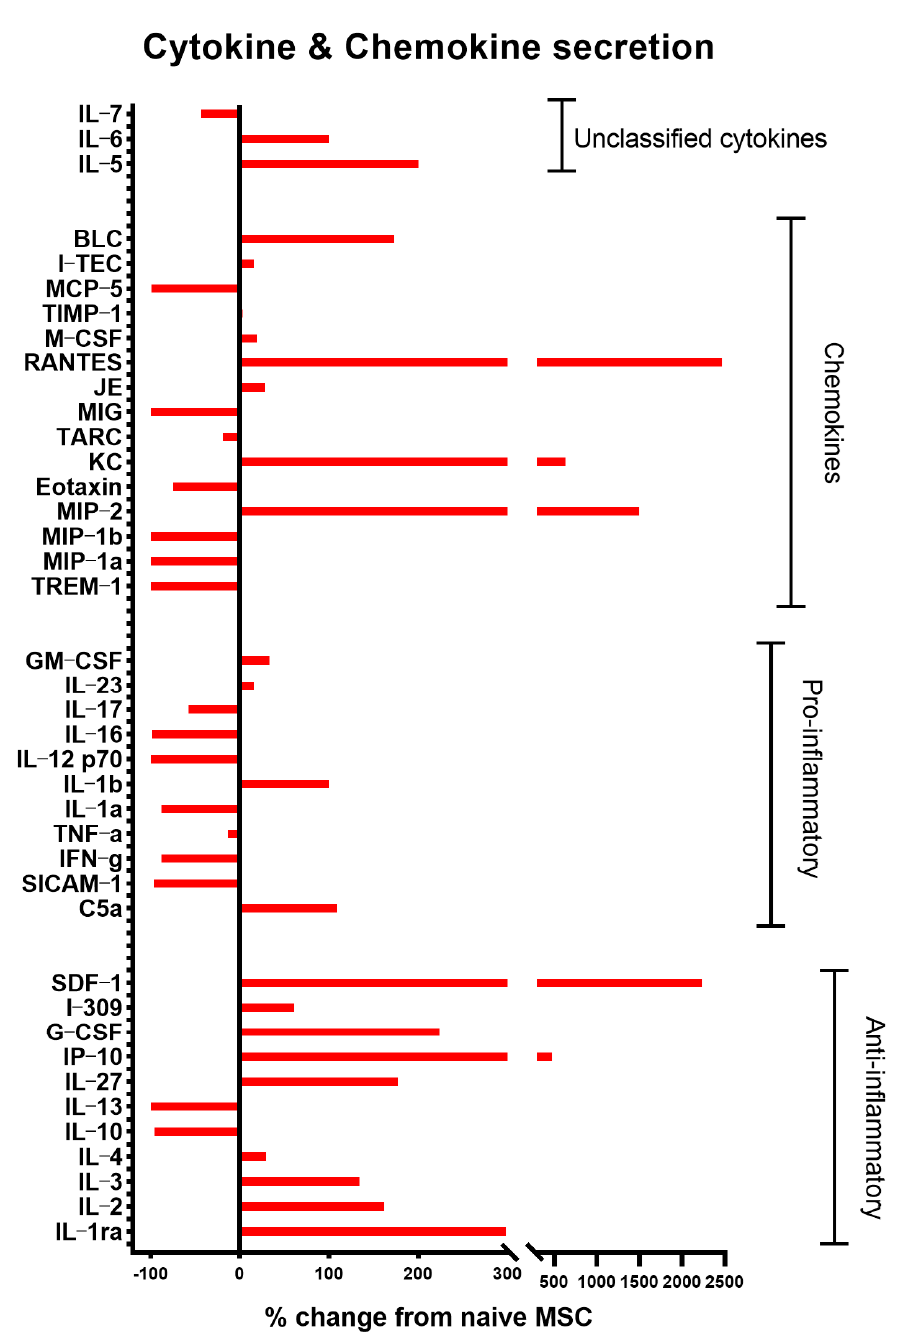
Figure 2. PACAP polarizes MSC towards an anti-inflammatory (MSC2) phenotype. Conditioned medium from naïve and PACAP-treated MSC was analyzed for chemokines and cytokines secretion, utilizing Proteome Profiler Mouse Cytokine Array (R&D Systems). The following chemokine and anti-inflammatory cytokines IL-2, IL-3, IL-4, IL-27, IP10, IL-1ra, RANTES, SDF-1, CCL2(JE), CCL1 (i-309), G-CSF, BLC were upregulated, while pro-inflammatory cytokines were downregulated (IL-6, IL-1a, IFN- È and soluble ICAM-1). Analysis was performed on pooled samples (n = 3) for each